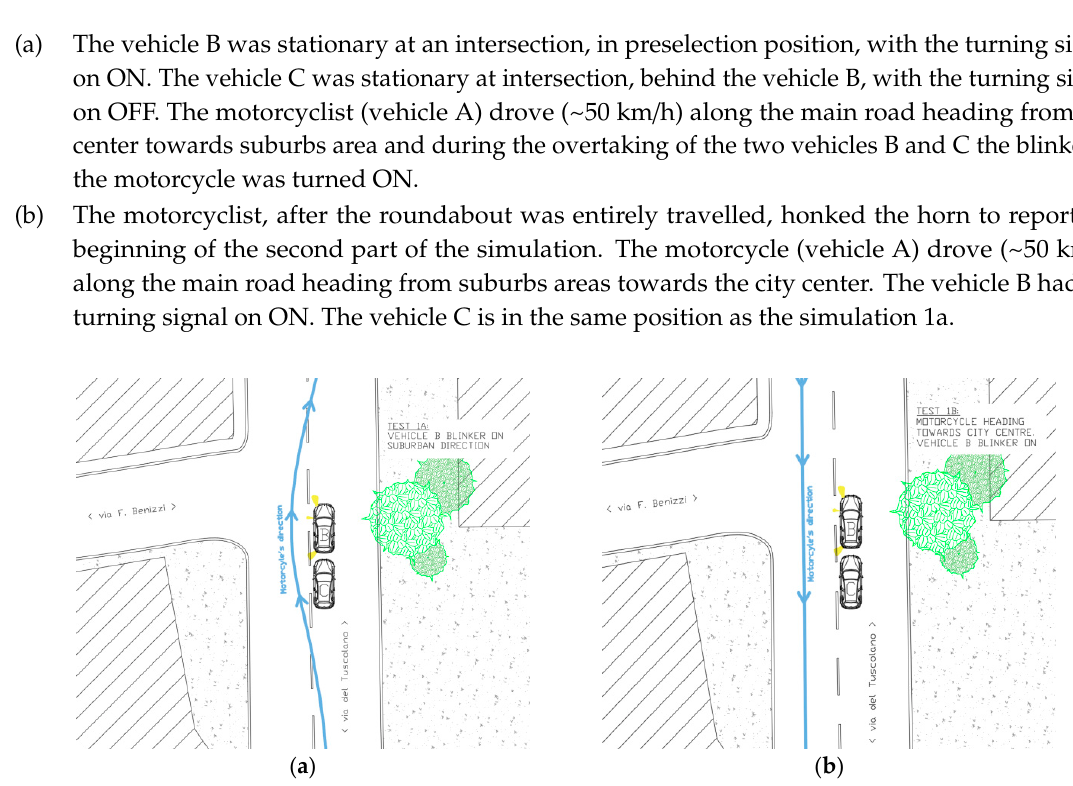
Figure 3. Simulation 1( a ) overtaking, and 1( b ) going through, schemes.